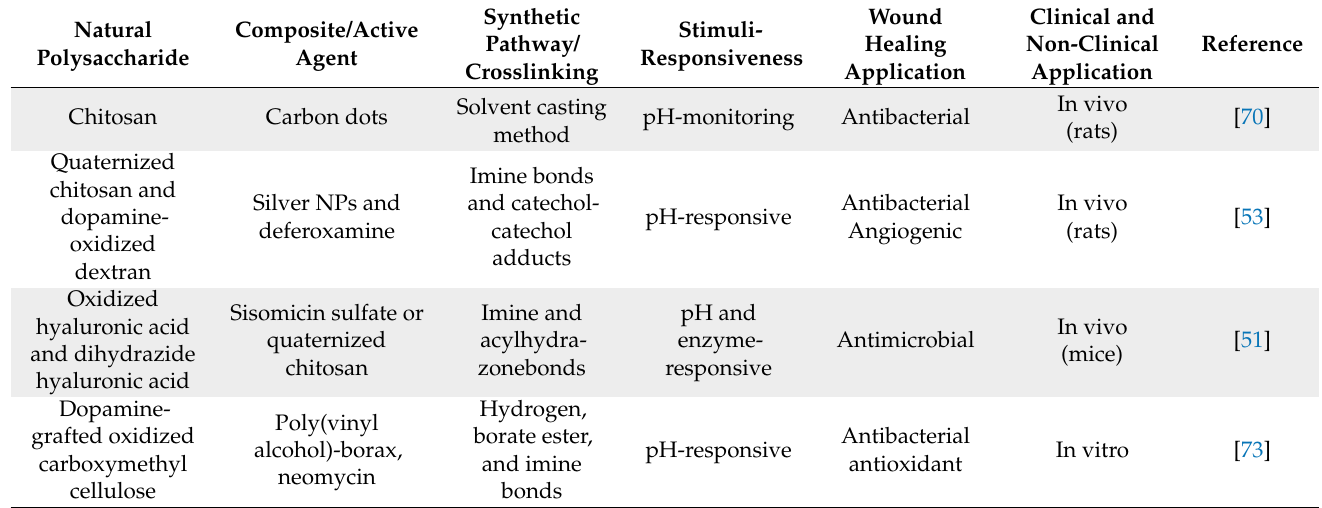
Table 2. Summary of the stimuli-responsive polysaccharide composites described in this